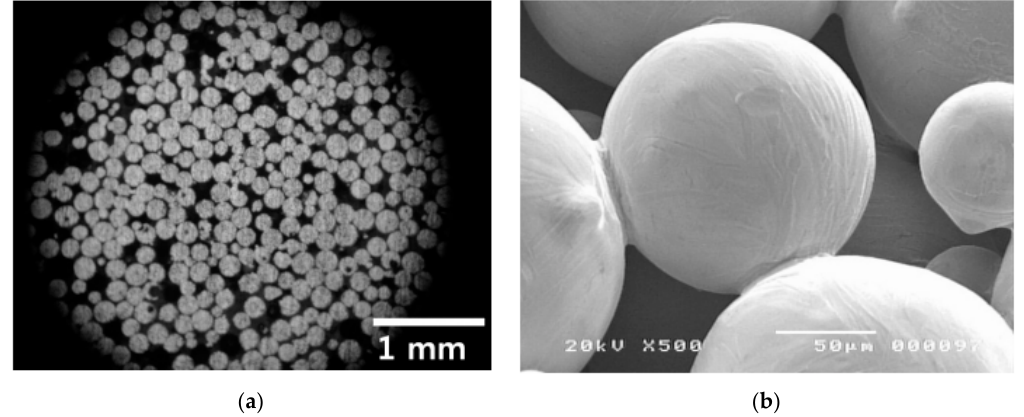
Figure 2. Necks formation during electrical discharge consolidation (EDC) with 1.07 kJ/g and low external applied pressure (7.8 MPa) on Ti powders: ( a ) cross section of the compact; ( b ) detail of the necks formed. Reprinted with permission from ref. [48], Copyright 2017 Polska Akademia Nauk.